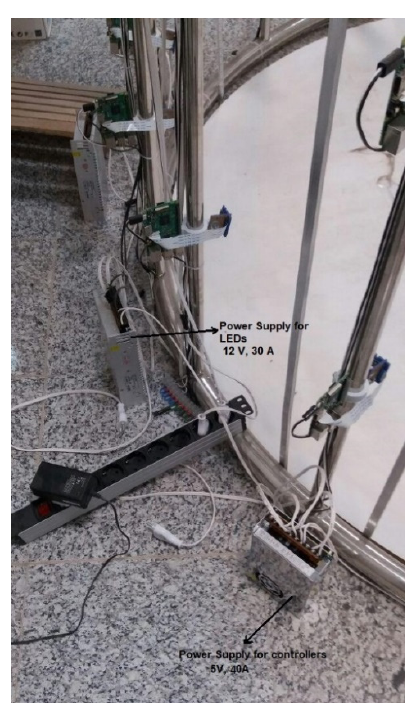
Figure 4. Power supply in the 3D scanning system.